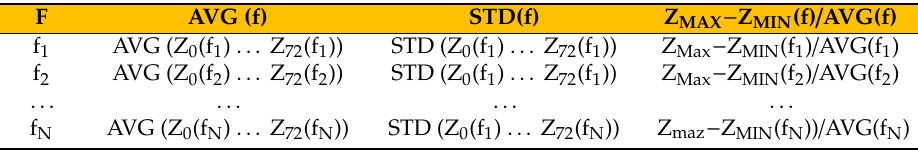
Table 5. Continuation of Table 1, AVG and STD